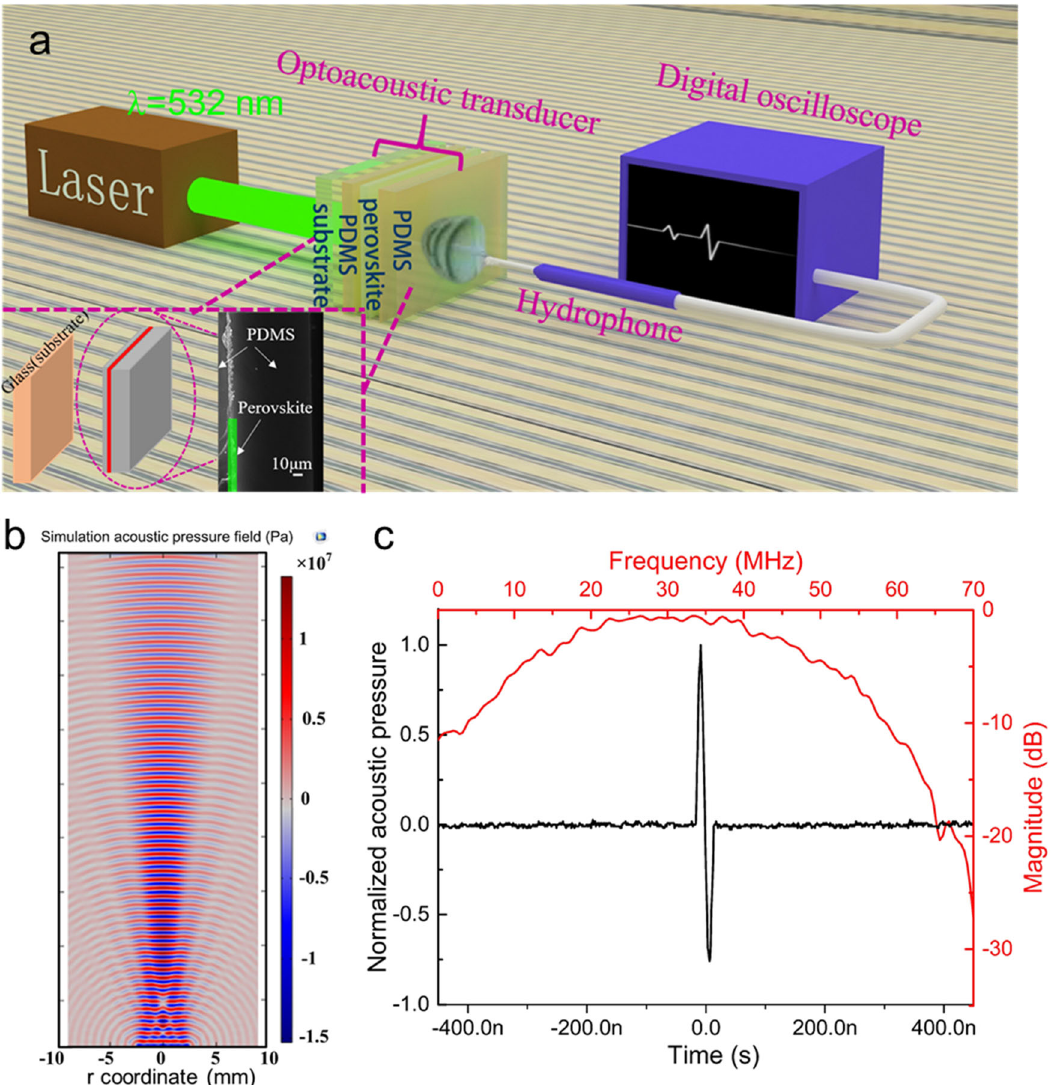
Fig. 1 Perovskite-based optoacoustic transducer. a Schematic illustration of the optoacoustic transducers and the characterization system. The inset is the device structure and the cross-sectional scanning electron microscope (SEM) image of the transducer. b The simulated distribution of the acoustic fi eld. c Experimentally measured acoustic wave (black curve) and spectrum (red curve) of the as-prepared optoacoustic